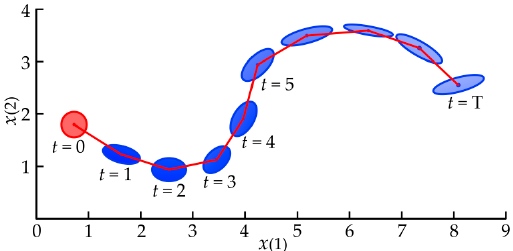
Figure 6. A conceptual illustration of long-term predictions of state evolution.